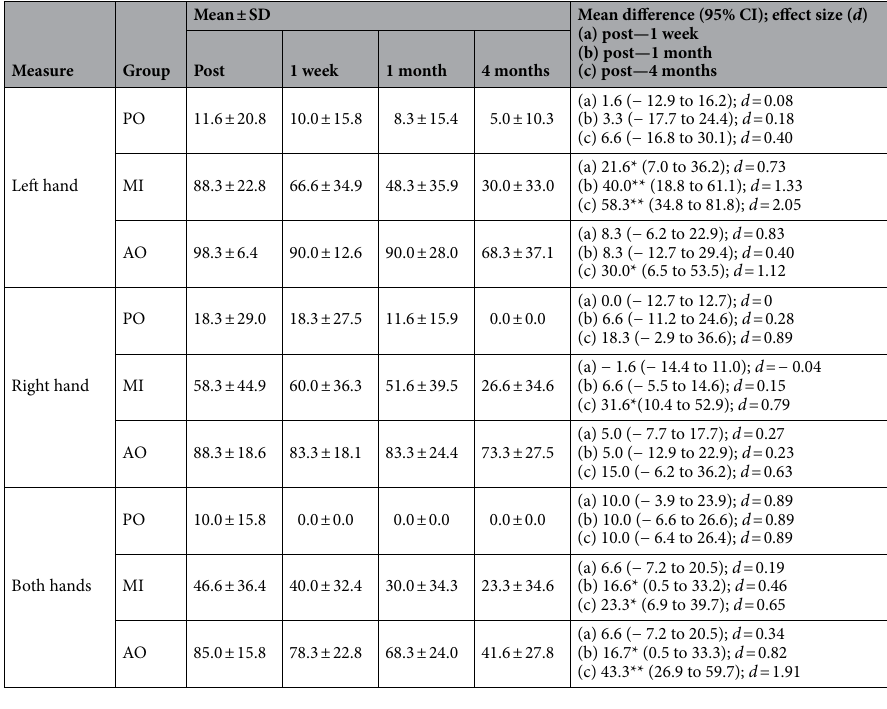
Table 4. Intragroup differences in perfect positions (%) outcome measure. *p < 0.05; **p < 0.001. AO action observation group, CI confidence interval, m month, MI motor imagery group, PO placebo observation group, SD standard deviation, w week.